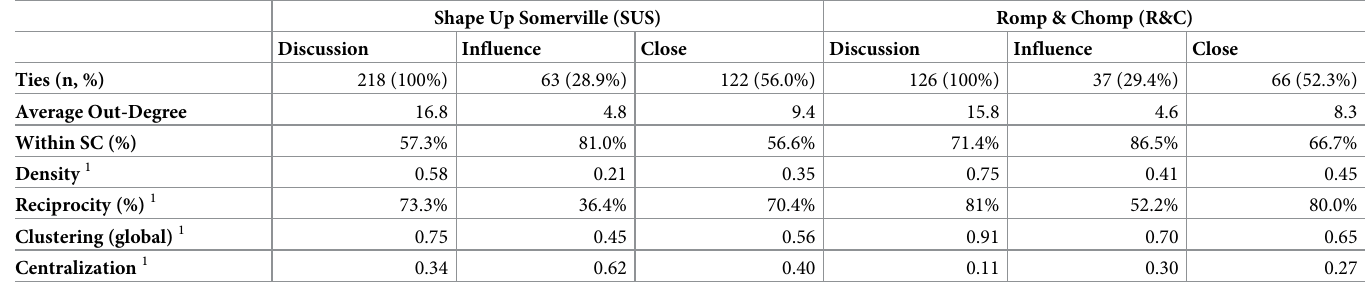
Table 3. Shape Up Somerville (SUS) and Romp and Chomp (R&C) steering committee network metrics.